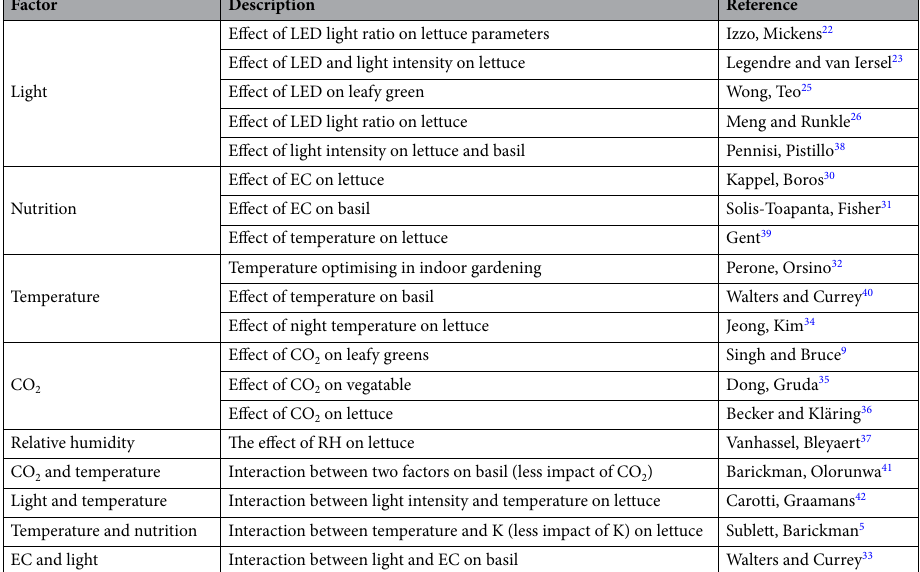
Table 1. Influential factors on growth of plants in vertical